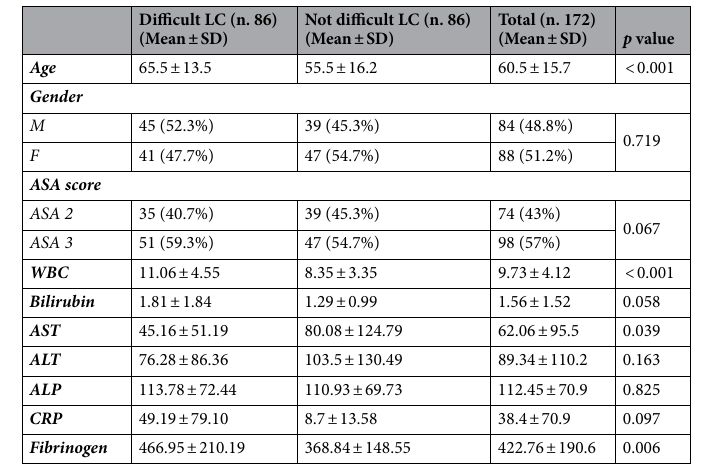
Table 1. Laboratory preoperative parameters between patients with difficult LC and not difficult LC.